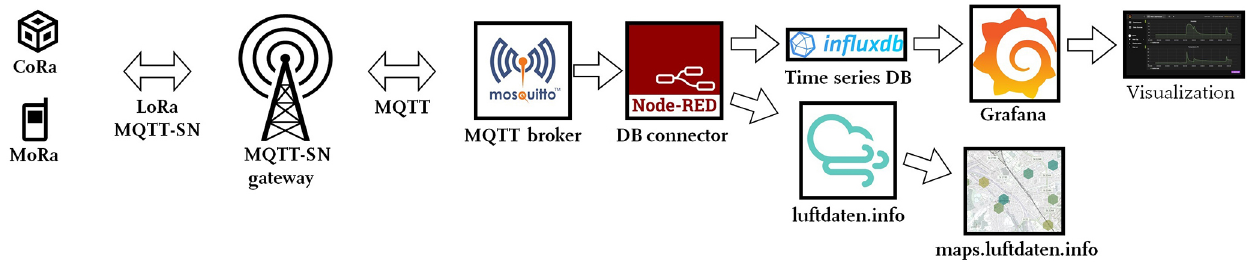
Figure 4. Sensing architecture.